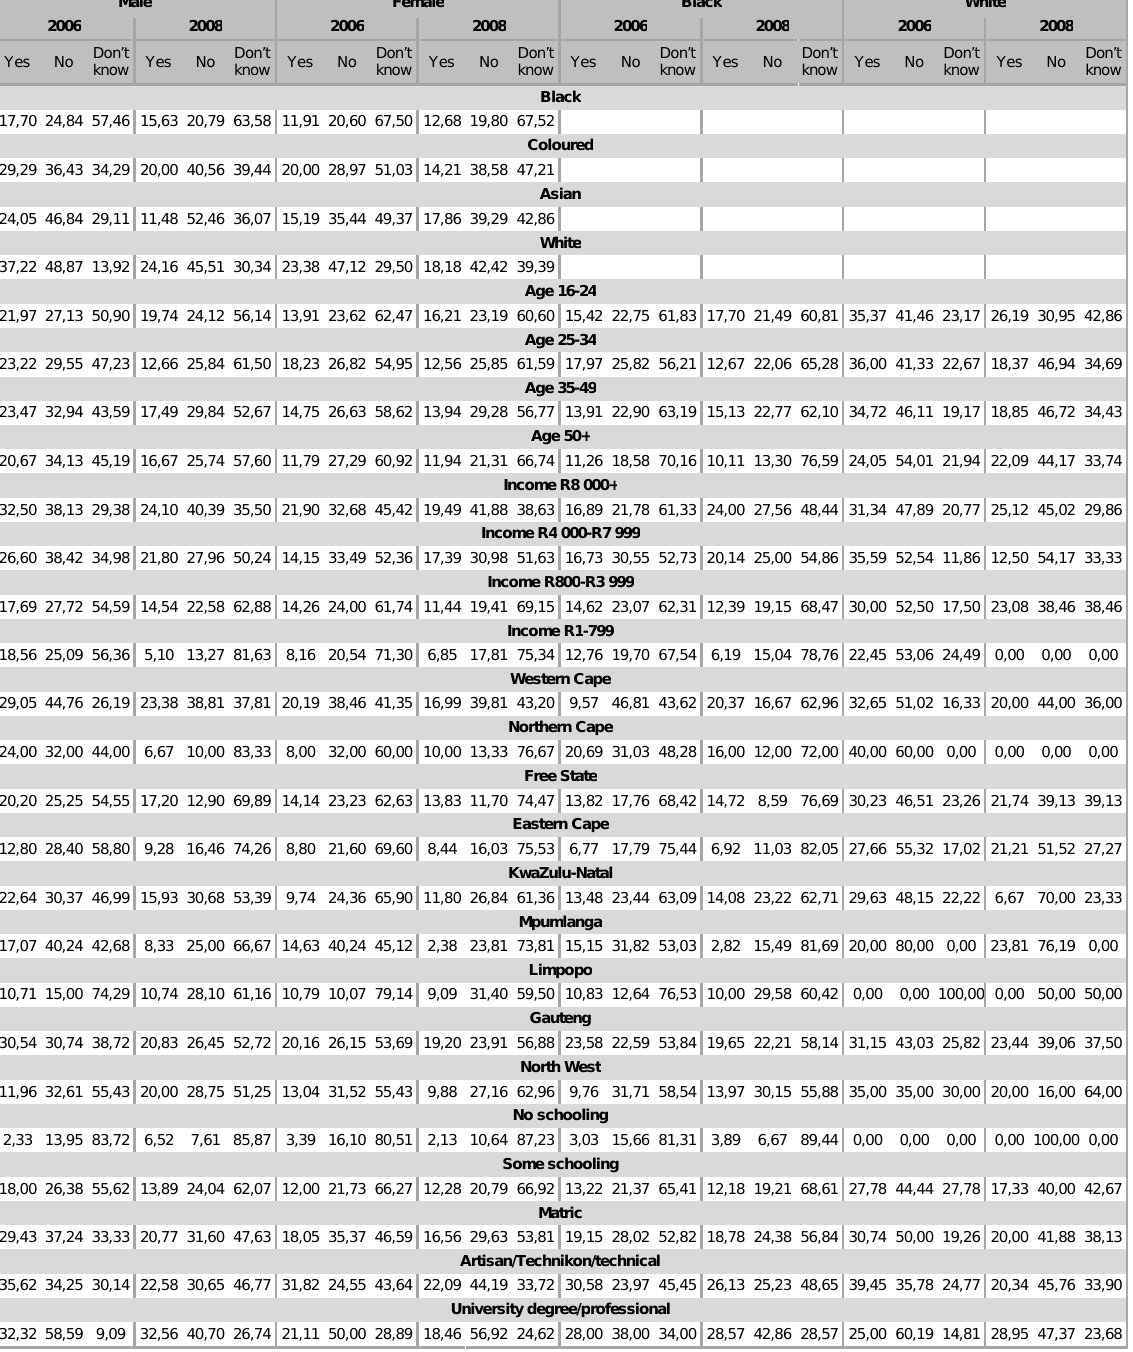
Sources: Ipsos-Markinor, 2006 and 2008; own